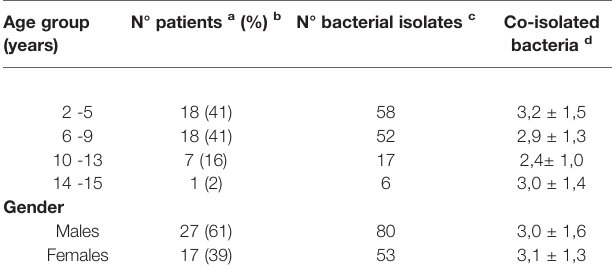
TABLE 1 | Basic demographic data of tonsils donors and number of viable bacteriological isolates produced by their samples. Age group (years)